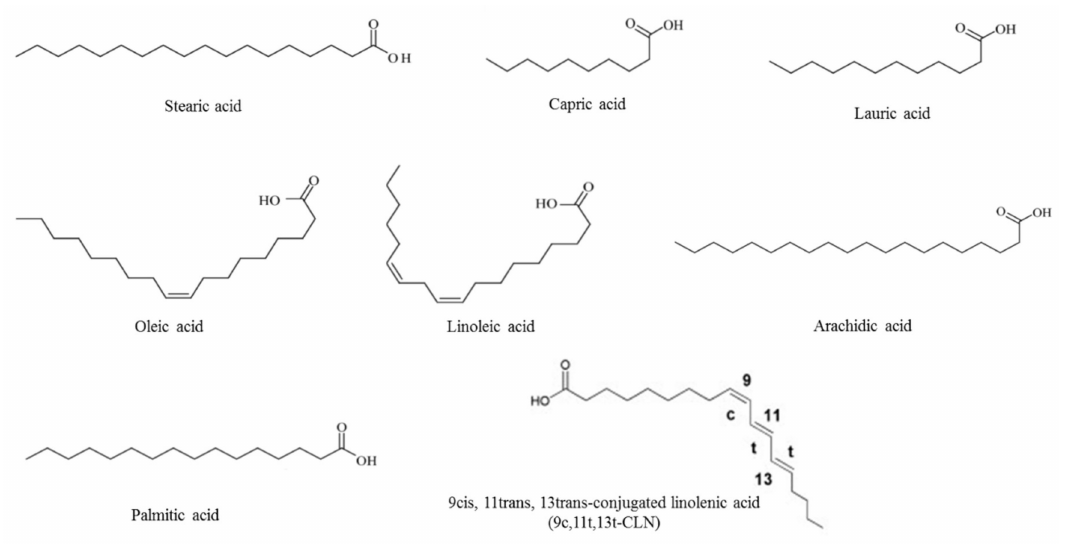
Figure 3. Chemical structure of fatty acids isolated from M. charantia